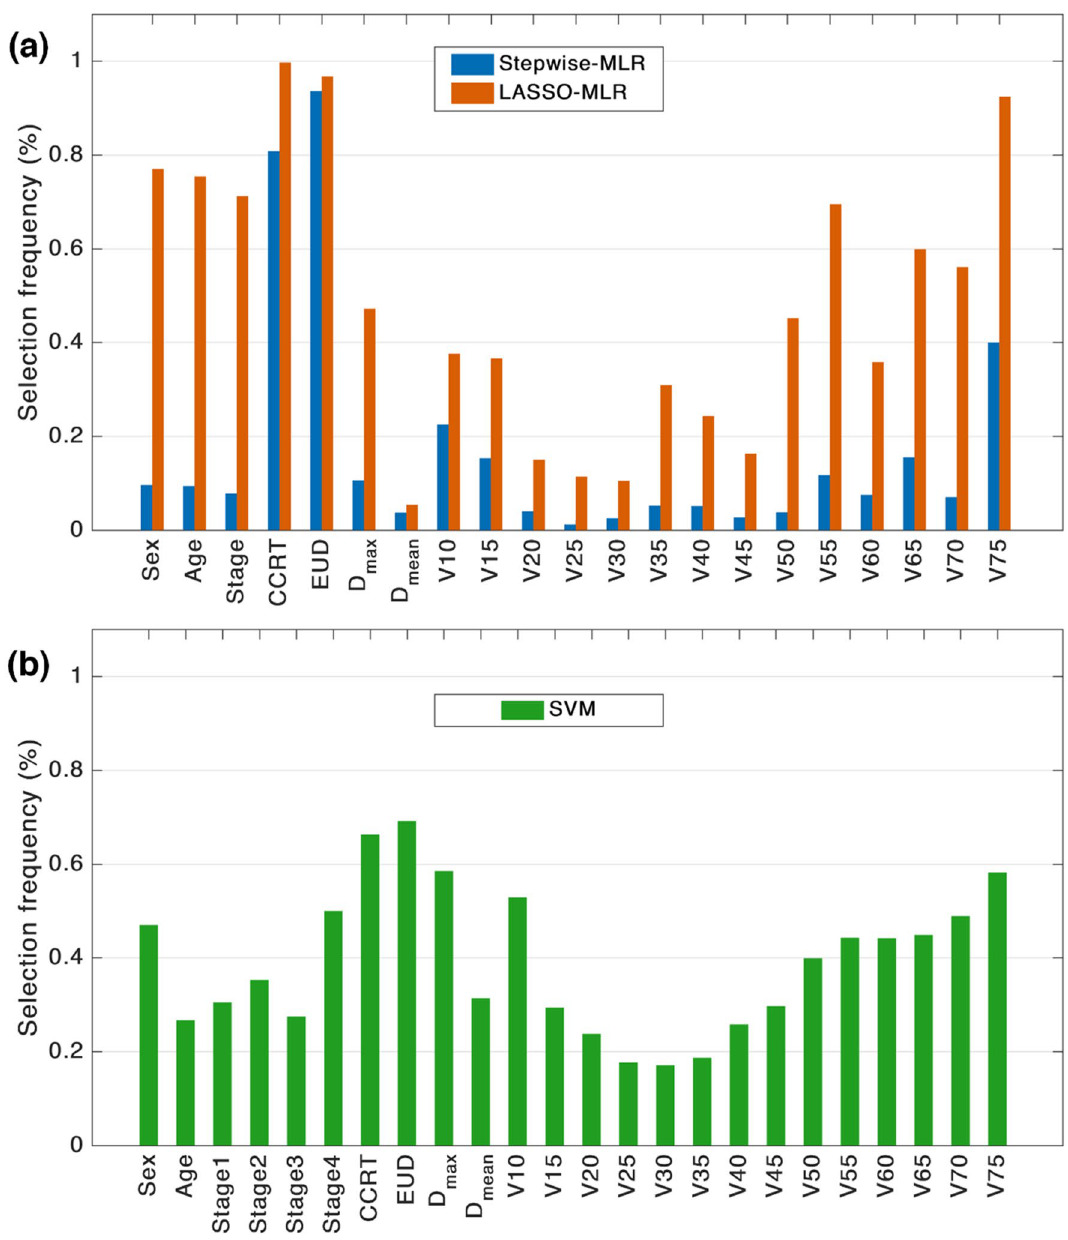
Figure 1. Selection frequencies of the candidate variables in 1000 bootstrapping samples by forward stepwise selection and LASSO for the MLR model ( a ), and by forward stepwise selection for the SVM model ( b